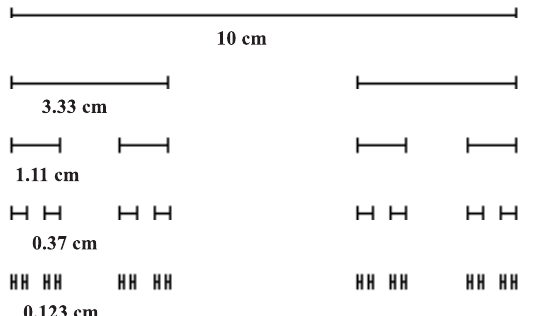
Figure 1. Cantor Bar with an initiator of 10 cm in length and fractal parameters D ≈≈≈≈≈ 0.6309 and b = 3.